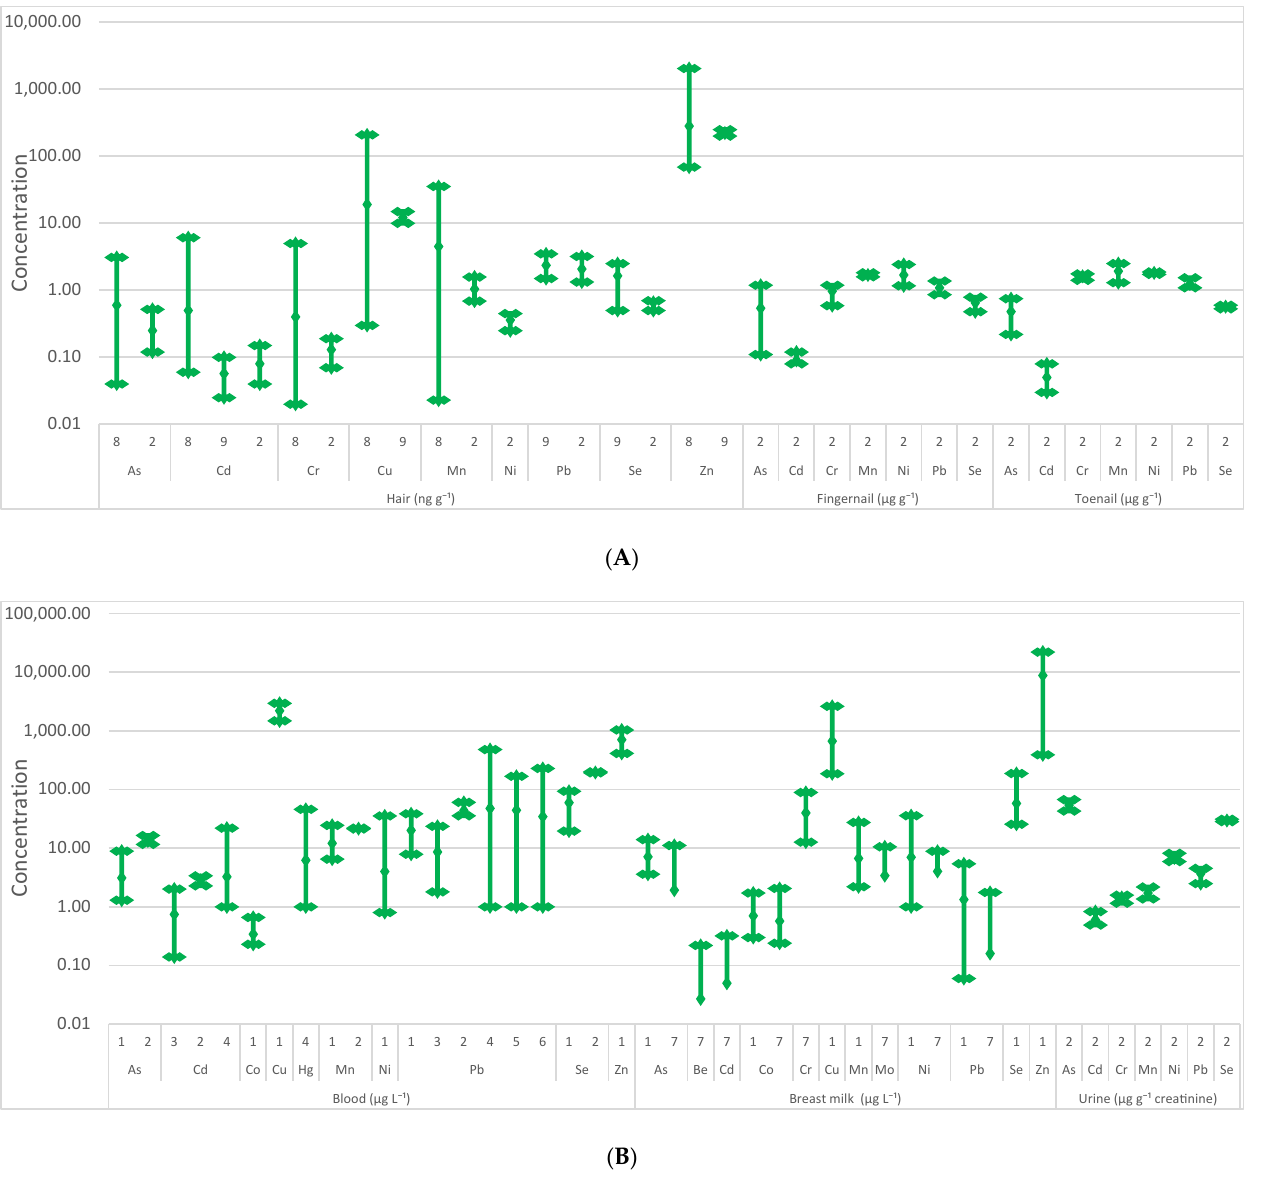
Figure 1. Minimum, maximum, and average concentration of heavy metals and metalloids in solid ( A ) and liquid ( B ) biological matrices among the Portuguese population. 1 [119]; 2 [114]; 3